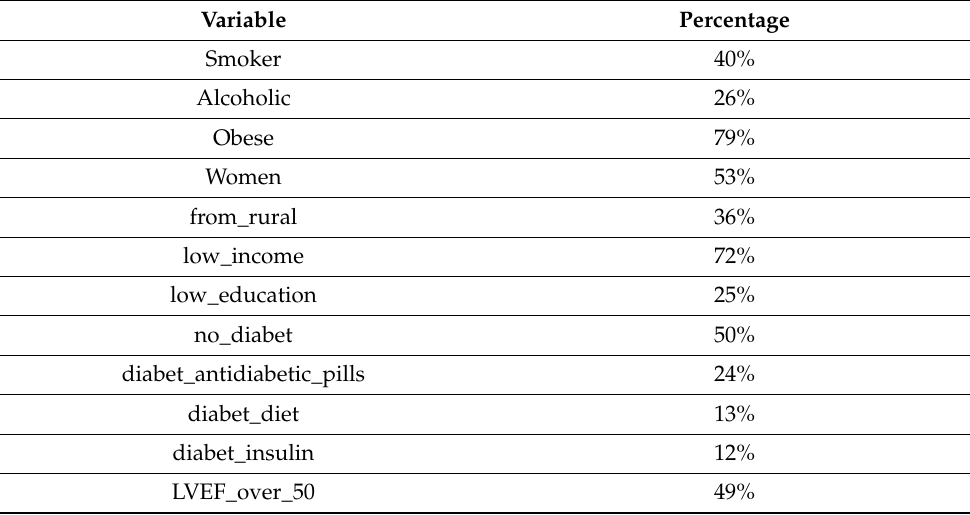
Table 1. The proportion of patients by each